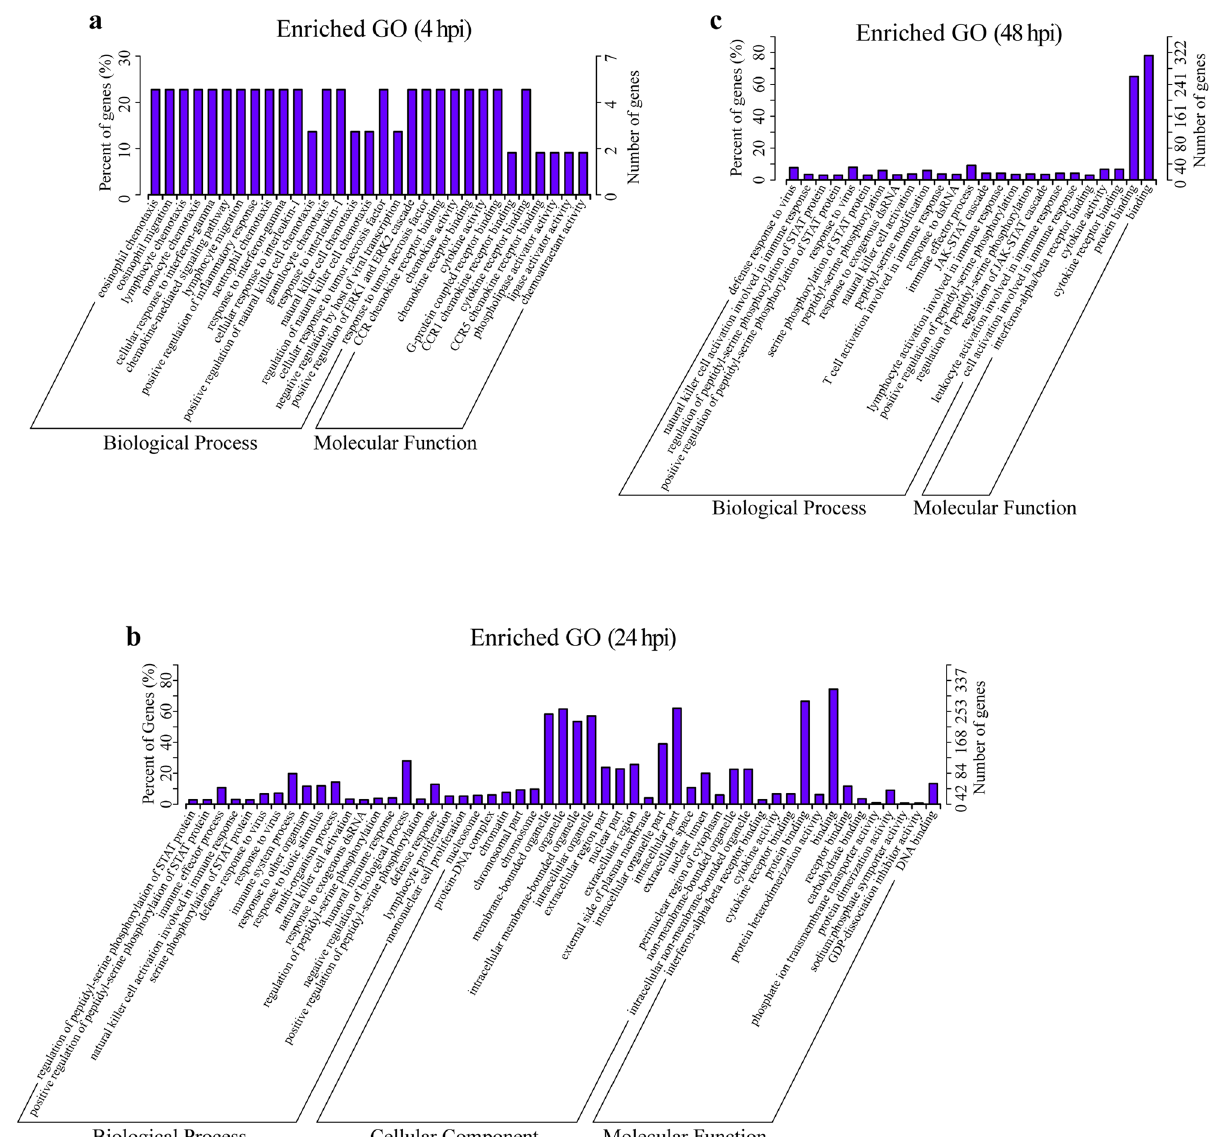
Figure 2. GO analysis of lncRNA target genes. GO analysis of cis predicted target genes of lncRNAs were differentially expressed in RAW264.7 cells with a Brucella abortus S2308 infection for 4 ( a ), 24 ( b ) and 48 ( c ) h, according to the corrected p -value (< 0.05). A total of 20 significant terms were shown and GO terms with no significance were enriched at 8 hpi. The x-axis indicates the GO terms under three subcategories: Biological Process, Cellular Component and Molecular Function. The left y-axis indicates gene percentages (numbers of enriched genes of each term divided by the total gene numbers), and the right y-axis indicates gene numbers for each